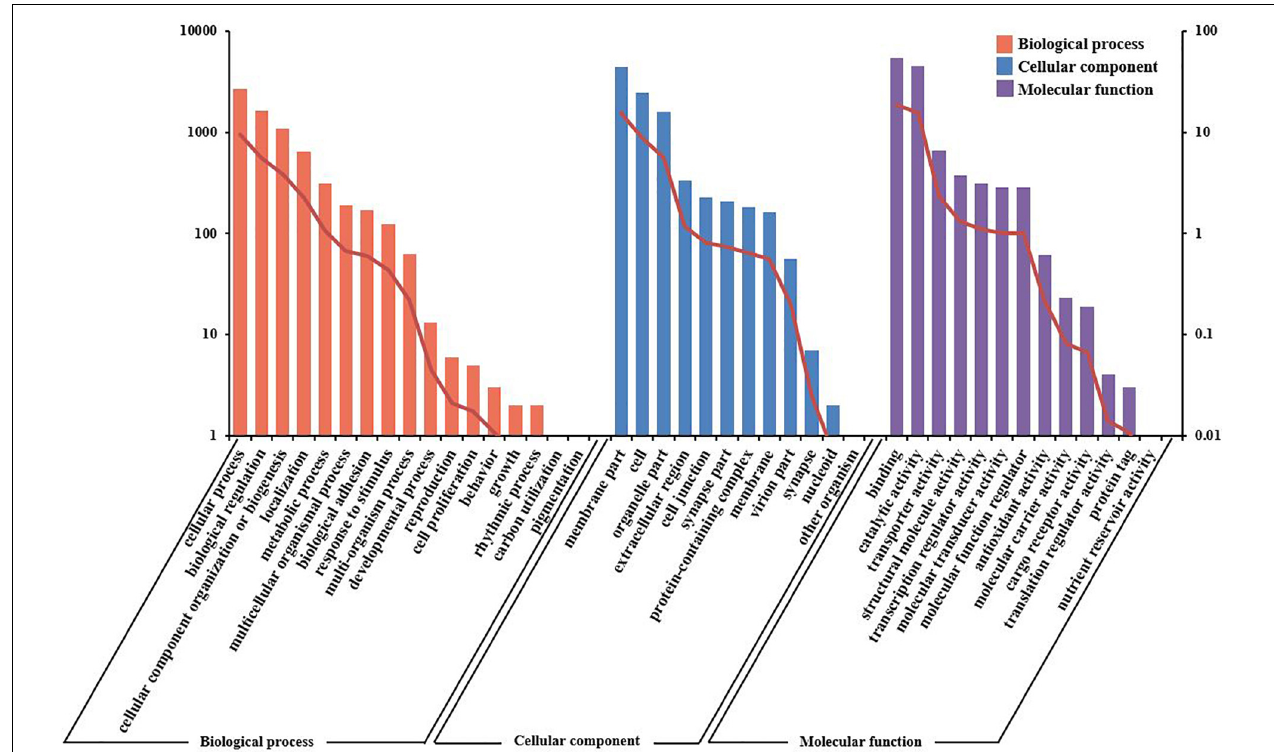
FIGURE 4 | Gene ontology (GO) terms and annotation of the integrated transcriptome assembly. Three main GO categories: cellular component, molecular function, and biological process. The X -axis indicates GO categories, while the Y -axis indicates the number of genes and percentage of genes.